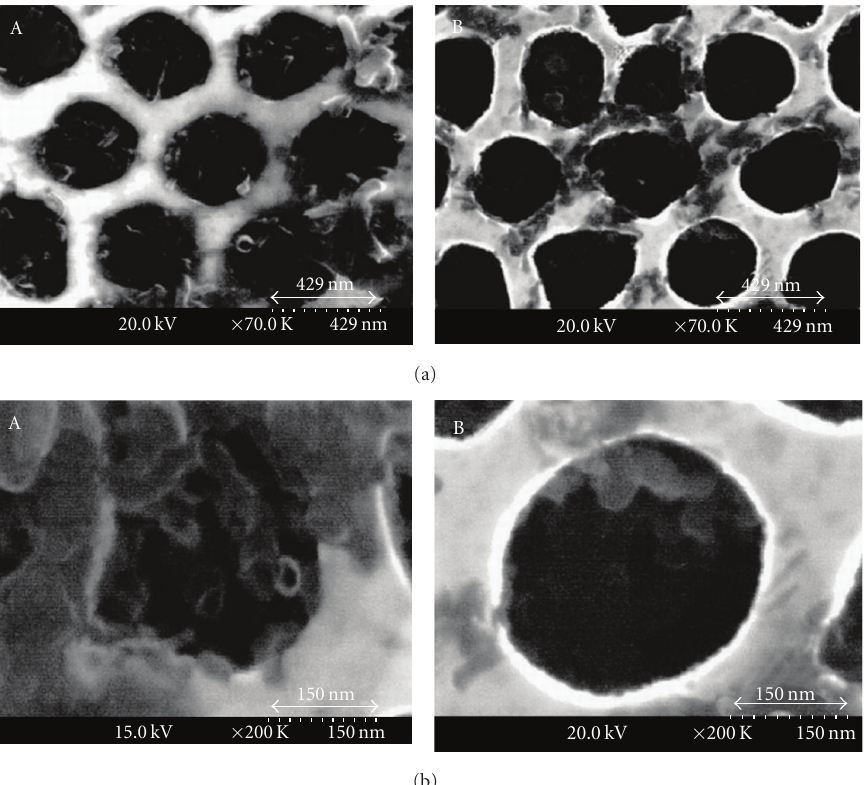
Figure 19: Top view of SEM images for a carbon nanotubes/nanoporous diamond composite electrode; (a) low magnification, and (b) high magnification images for (A) HD CNT-NANO and (B) LD CNT-NANO (reprinted with permission from